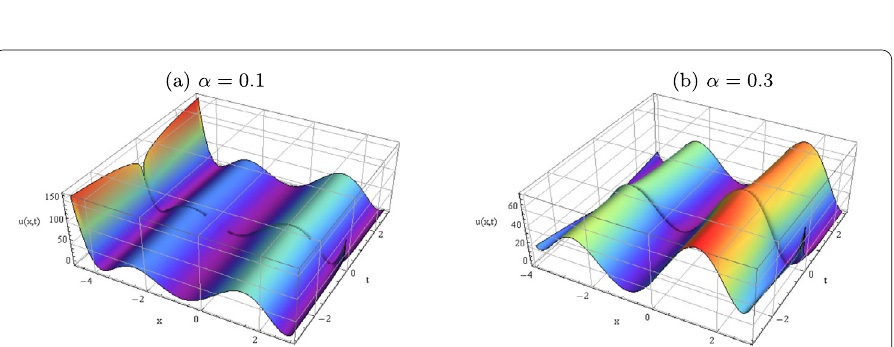
Figure 1 ( a ) The effect of α on the 3D solitary wave solution of equation (5.10) with a fixed time t and the parameters k = 0.3, p = 0.2, q = 0.7, r = 0.3, a 0 = 6, a 1 = 1.7. ( b ) The corresponding 2D plot of ( a ), which shows that the envelope of the wave decays far away from the peak quickly when the value of α increases meaning that the solitary wave solution behaves as a dynamical system